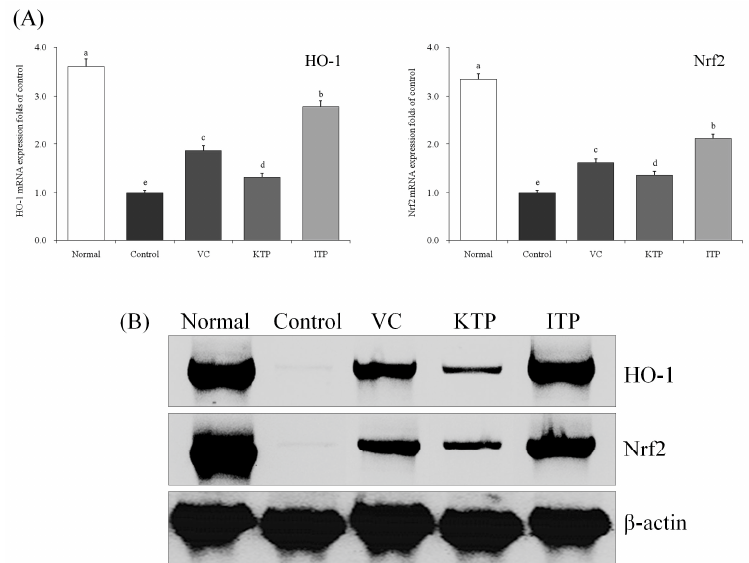
Figure 8. Expression of mRNA ( A ) and protein ( B ) for HO-1 and Nrf2 in liver of mice. a–e Mean values with different letters in the same bar represent significant differences ( p < 0.05) according to Duncan’s multiple-range test. VC: vitamin C (200 mg/kg body weight); KTP: Kuding tea polyphenols (200 mg/kg body weight); ITP: insect tea polyphenols (200 mg/kg body weight).